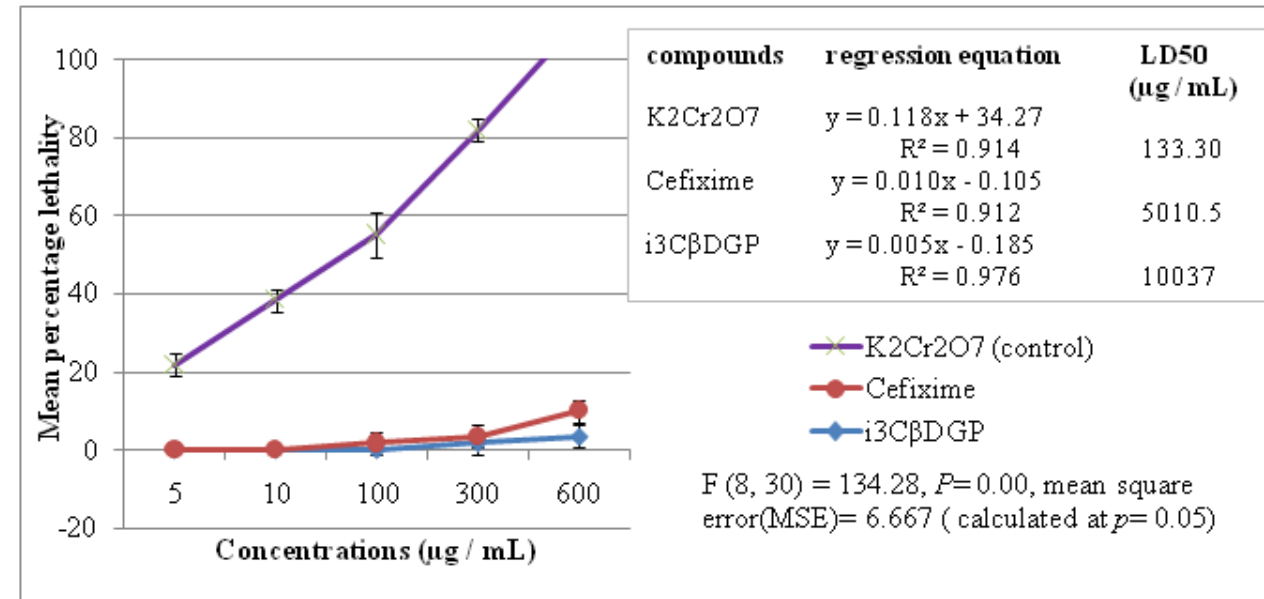
Figure 5. The cytotoxicity determination of iriflophenone-3-C- β D glucopyranoside (i3c β DGP) and its comparison with antibiotic (Cefixime) and control (K 2 Cr 2 O 7 ). Data on top right corner show the LD 50 .